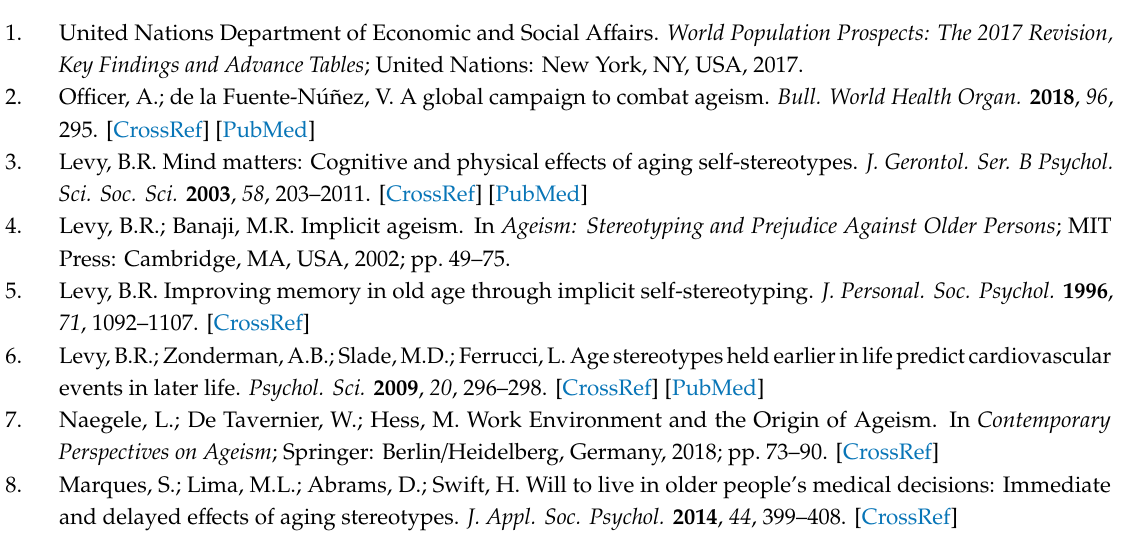
Table S1: Inclusion and exclusion criteria for study selection; Table S2: Search string for Pubmed search; Table S3: Country of origin and measure of ageism of studies included in this review; Table S4: Determinants of “other-directed” forms of ageism explored in more than three studies (total N = 188); Table S5: Determinants of “other-directed” forms of ageism explored in less than three studies (total N = 188); Table S6: Determinants of “self-directed” forms of ageism explored in more than three studies (total N = 20); Table S7: Determinants of “self-directed” forms of ageism explored in less than three studies (total N = 20); Figure S1: Summary of the quality of the studies assessment; Table S8. Quality of the evidence score; Table S9: PRISMA